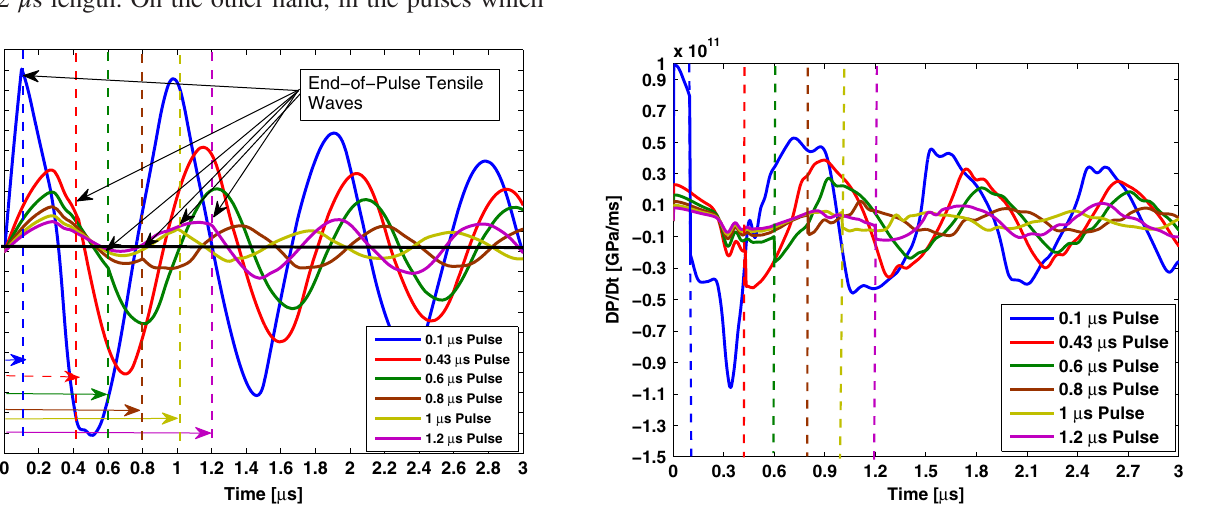
FIG. 10. Parametric study showing the pressure response in the center of the target core (gauge 7) for different proton pulse lengths. End-of-pulses tensile waves can be easily appreciated in the plot, as well as their amplifying effect when they are in phase with the natural radial waves. Compare 0 . 8 μ s pulse length (brown) with 1 . 2 μ s (purple), higher tensile pressure are reached in the former even if energy is deposited in a slower fashion.